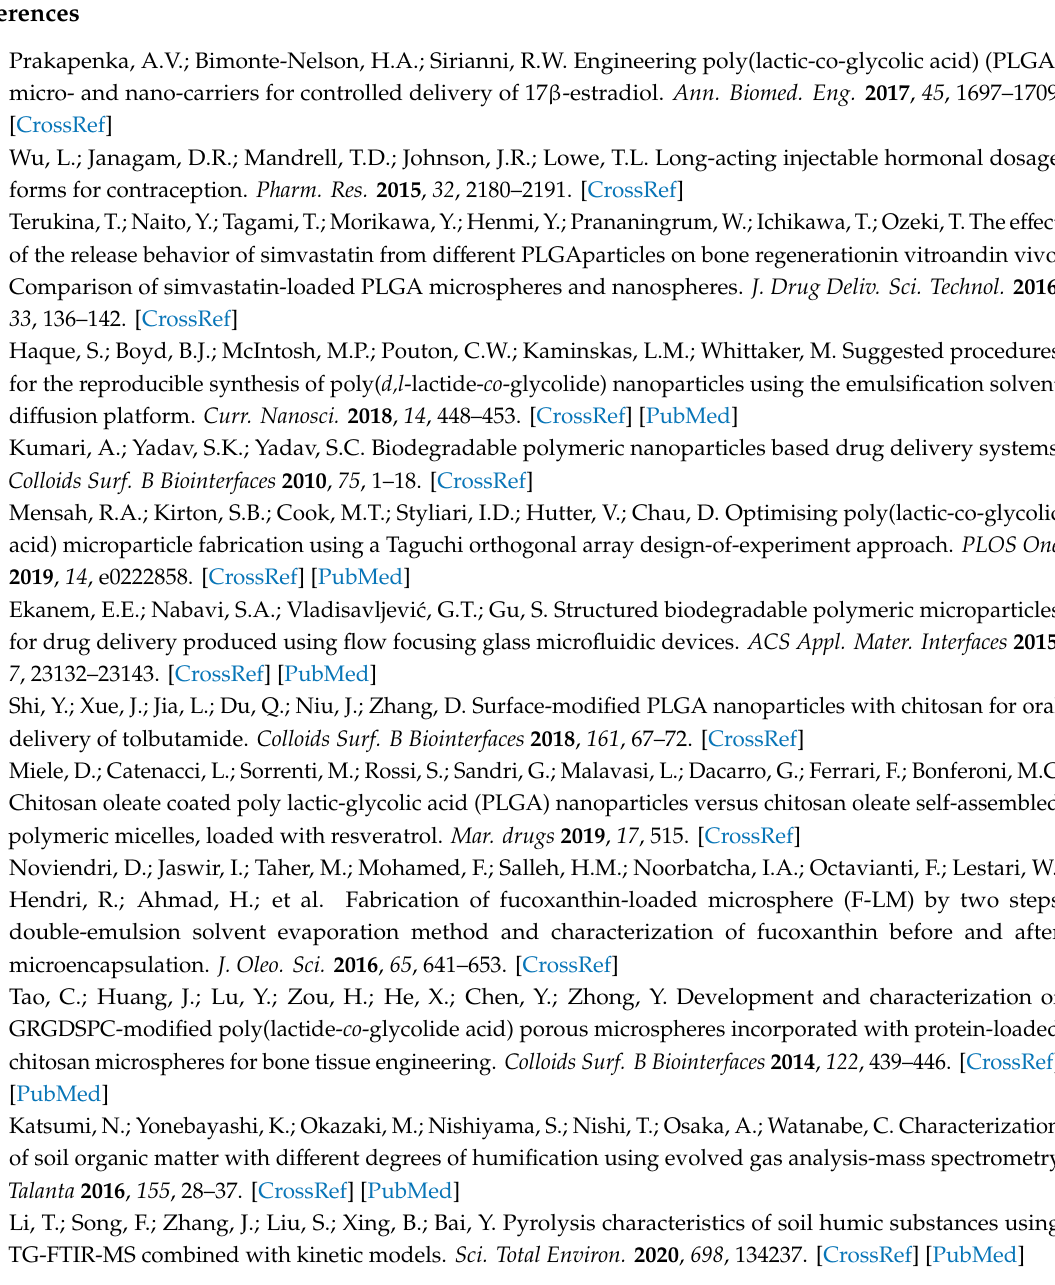
Figure S2. SEM micrographs of (a) blank PLGA microspheres and (b) those with the actual progesterone payload of 18.5%. The microspheres were prepared by the solvent evaporation process using methylene chloride. The size bar is 100 µ m. Figure S3. (Left) GC chromatograms of microsphere samples subjected to our GC analytical procedure. Arrows indicate the peaks of ethyl formate (EF), ethyl acetate (EA), and methylene chloride (MC). (Right) Standard calibration curves of the peak areas ratios vs. an analyte (ethyl formate, or methylene chloride)